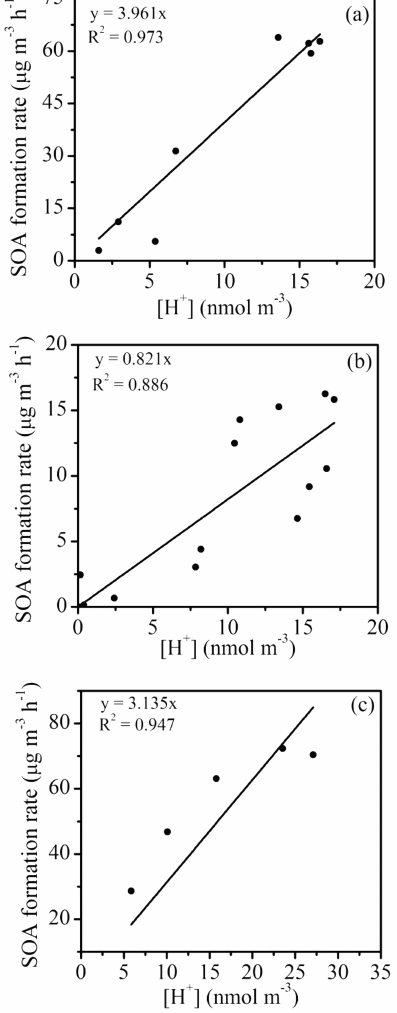
Figure 10. SOA formation rate as a function of in situ particle acid- ity ([H + ]) for vehicle I (a) , vehicle II (b) , and vehicle III (c) with addition of SO 2 . Plotted data were selected from when SOA forma- tion rate was higher than zero to when the rate reached the maxi- mum